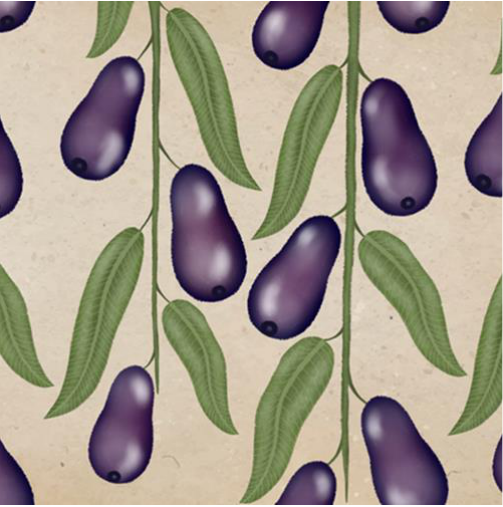
Figure 4. Jambolan ( S. cumini ). Illustration made by the Ribeiro, L.V. (2022).